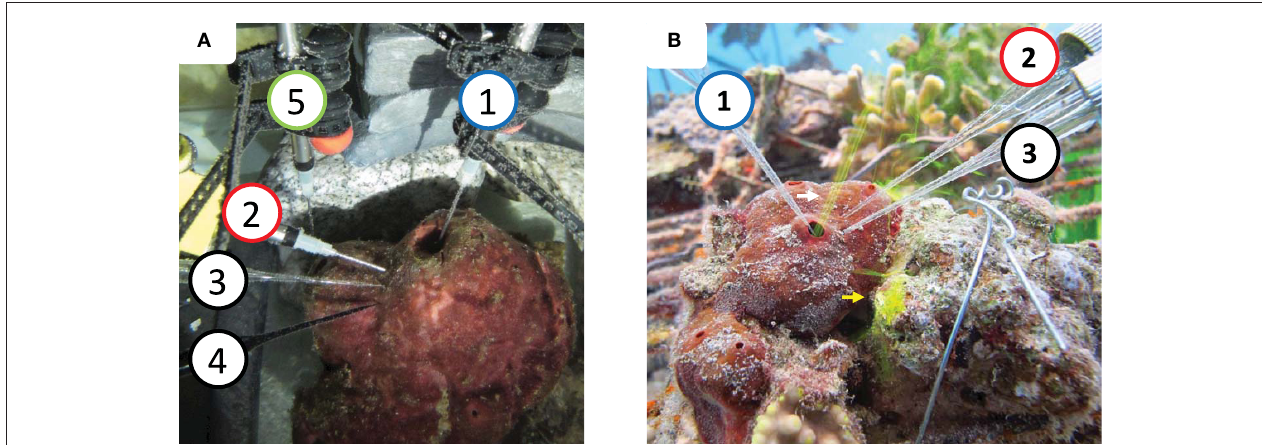
FIGURE 1 | System setup (A) in a running seawater aquaria. (B) In situ. (1) Dissolved oxygen (DO) sensors in the osculum measuring the DO levels in the water exhaled by the sponge [micro-optode in (A) , micro-electrode in (B)] . (2) DO sensor inserted ∼ 0.8–10 mm into the sponge body to measure internal DO levels [micro-optode in (A) , micro-electrode in (B)]. (3) RedOx and (4) sulfide micro-electrodes inserted ∼ 8–10 mm into the body. DO sensor (5) (micro-optode) inserted to the small osculum. Fluorescein dye (0.2 µ m filtered) was released near the dermal surface of the sponge to be pumped in (yellow arrow). Flow through the osculum (white arrow) was used to assess sponge pumping activity. RedOx and sulfur data are not presented in the current manuscript.